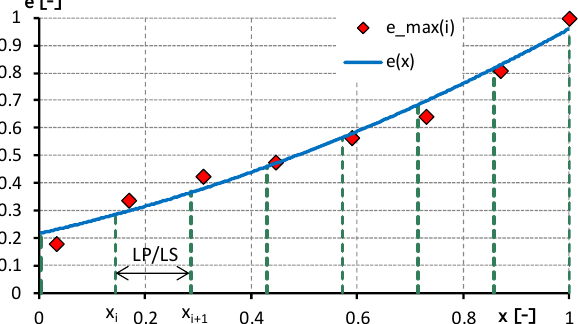
Figure 4. Local maxima of non-dimensional gas kinetic energy e max ( i ) in the staggered seal with the approximating line e ( x ); discontinuous green line shows the location of tooth sidewalls on the inflow side (the distance between them is LP ).